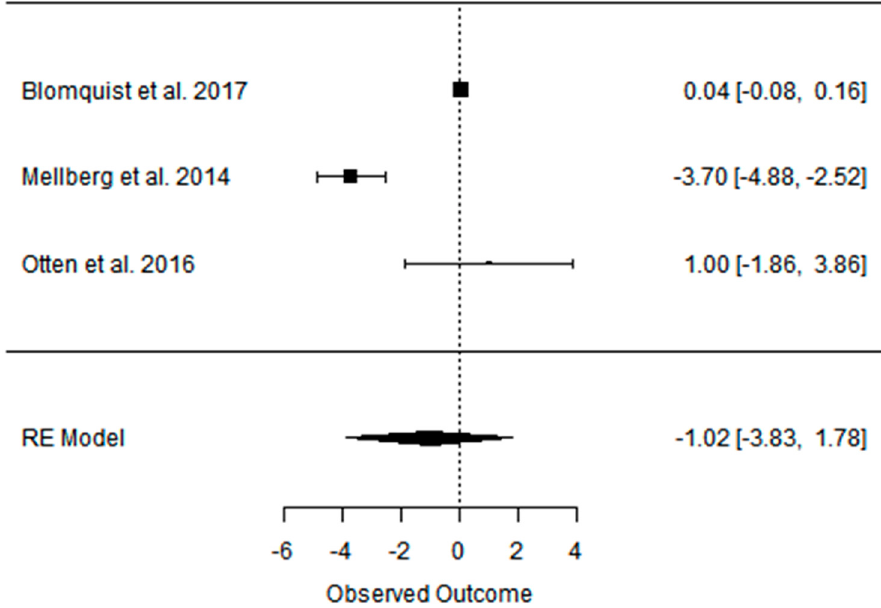
Figure A40. Forest plot of the effect of a PD on SBP in the long term (weighted mean difference).